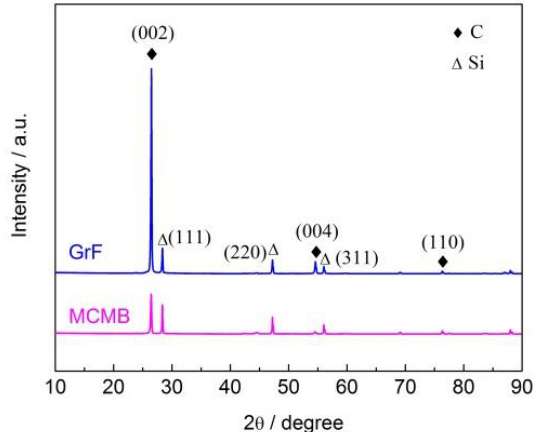
ff raction patterns of the MCMB and GrF Figure 5. X-ray diffraction patterns of the MCMB and GrF powders. Figure 5. X-ray di